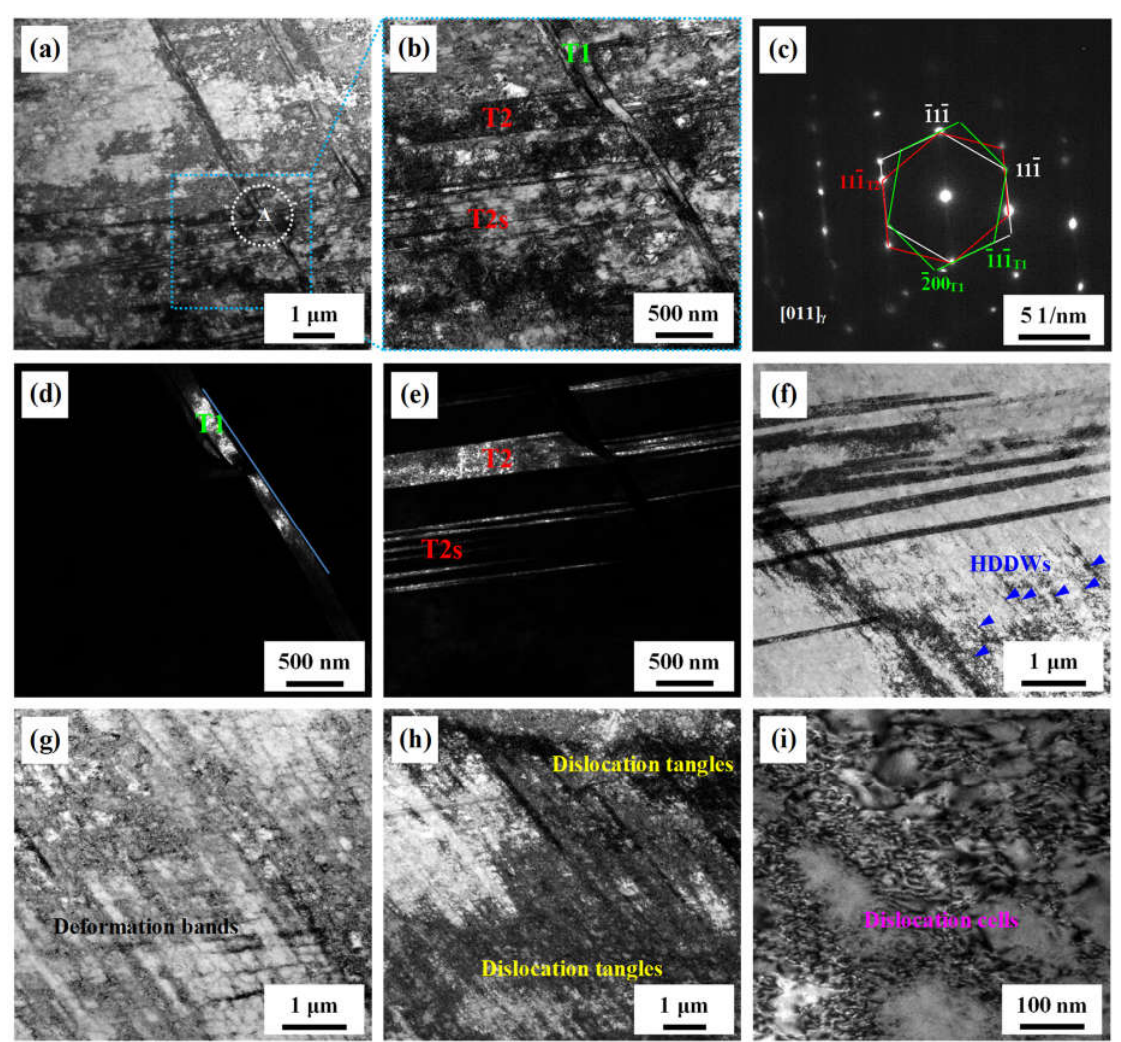
Figure 5. TEM images of typical microstructures of the steel after tensile deformation at 298 K. ( a ) and ( b ): Bright-field TEM images, exhibiting clear contrast of two-variant mechanical twins, and ( b ) is an enlarged image of the square outlined region in ( a ). ( c ) SAEDP of the outlined region A in ( a ). ( d ) and ( e ): Corresponding dark-field TEM images obtained from the ( 2 00 ) T1 and 111 reflections in ( c ). ( f )–( i ): Bright-field TEM image, showing HDDWs, deformation bands, dislocation tangles and dislocation cells.